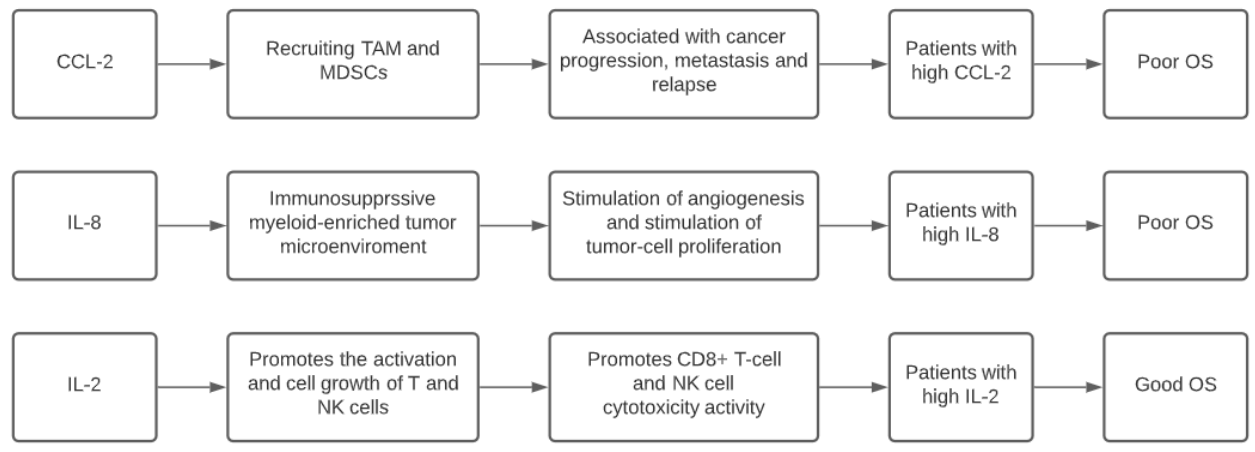
Figure 2. Most significant cytokines at T0, their functional meanings and effects of higher values on the patient’ outcome. MDSC: myeloid derived suppressor cells; TAM: tumour associated macrophages; NK: natural